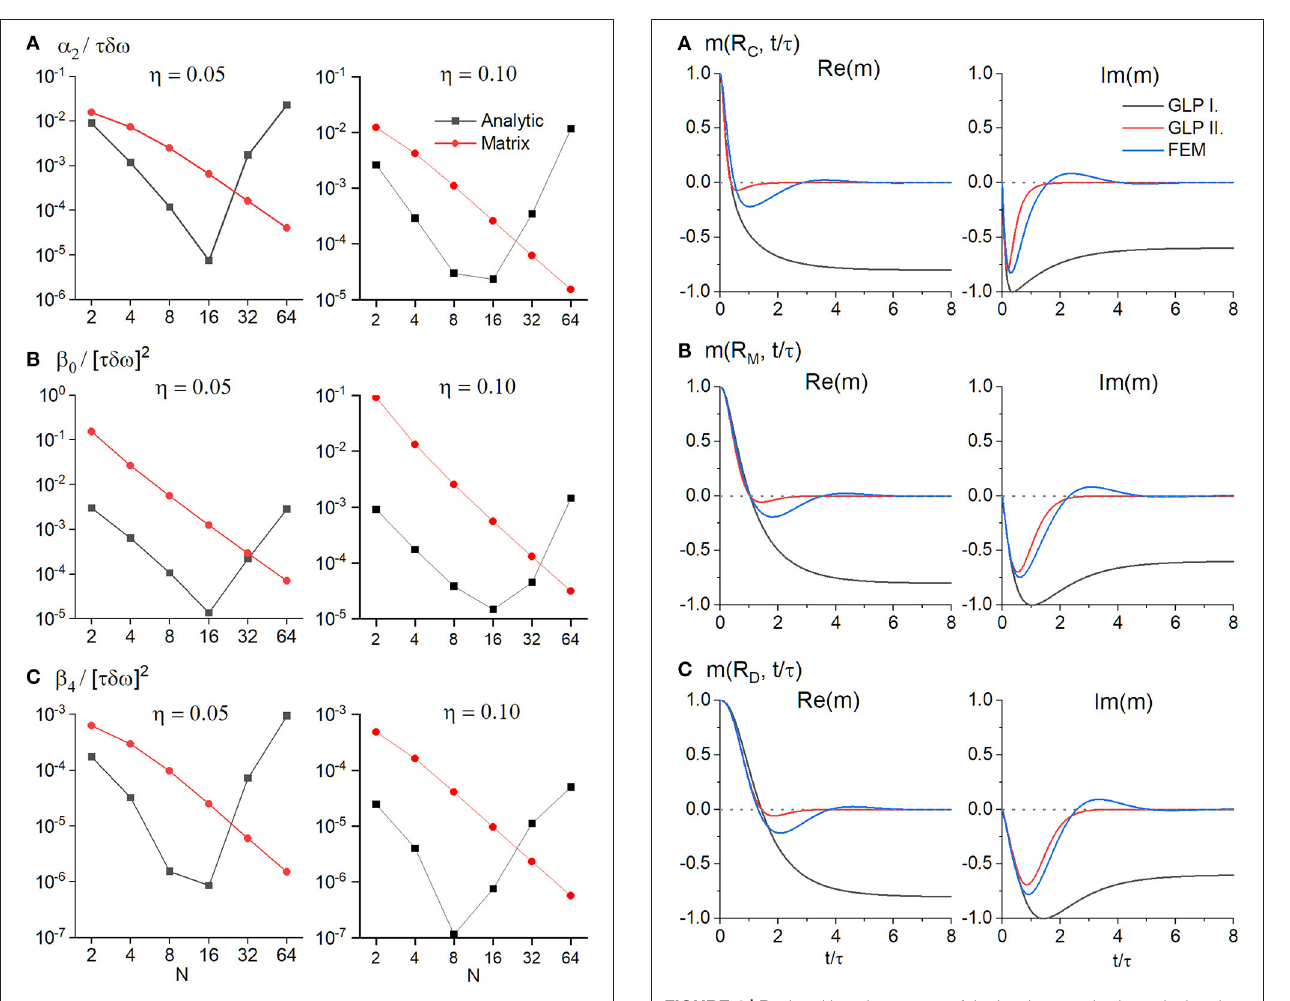
FIGURE 3 | Root mean squared error between the true time evolution of the moment functions α 2 ( R C , t ) (A) , β 0 ( R C , t ) (B) , and β 4 ( R C , t ) (C) as determined by a finite element simulation of Equations (33)–(35) and either the analytical solution according to Equations (36)–(38) or the finite difference solution according to Equations (73), (78), and (79). The time evolution was calculated from t /τ 0 to t /τ 10 in steps of 0.1 either for η 0.05 (left side) or = = = η 0.1 (right side). The abscissa represents either the number of considered = eigenvalues for the analytic solution or the matrix dimension for the matrix solution.